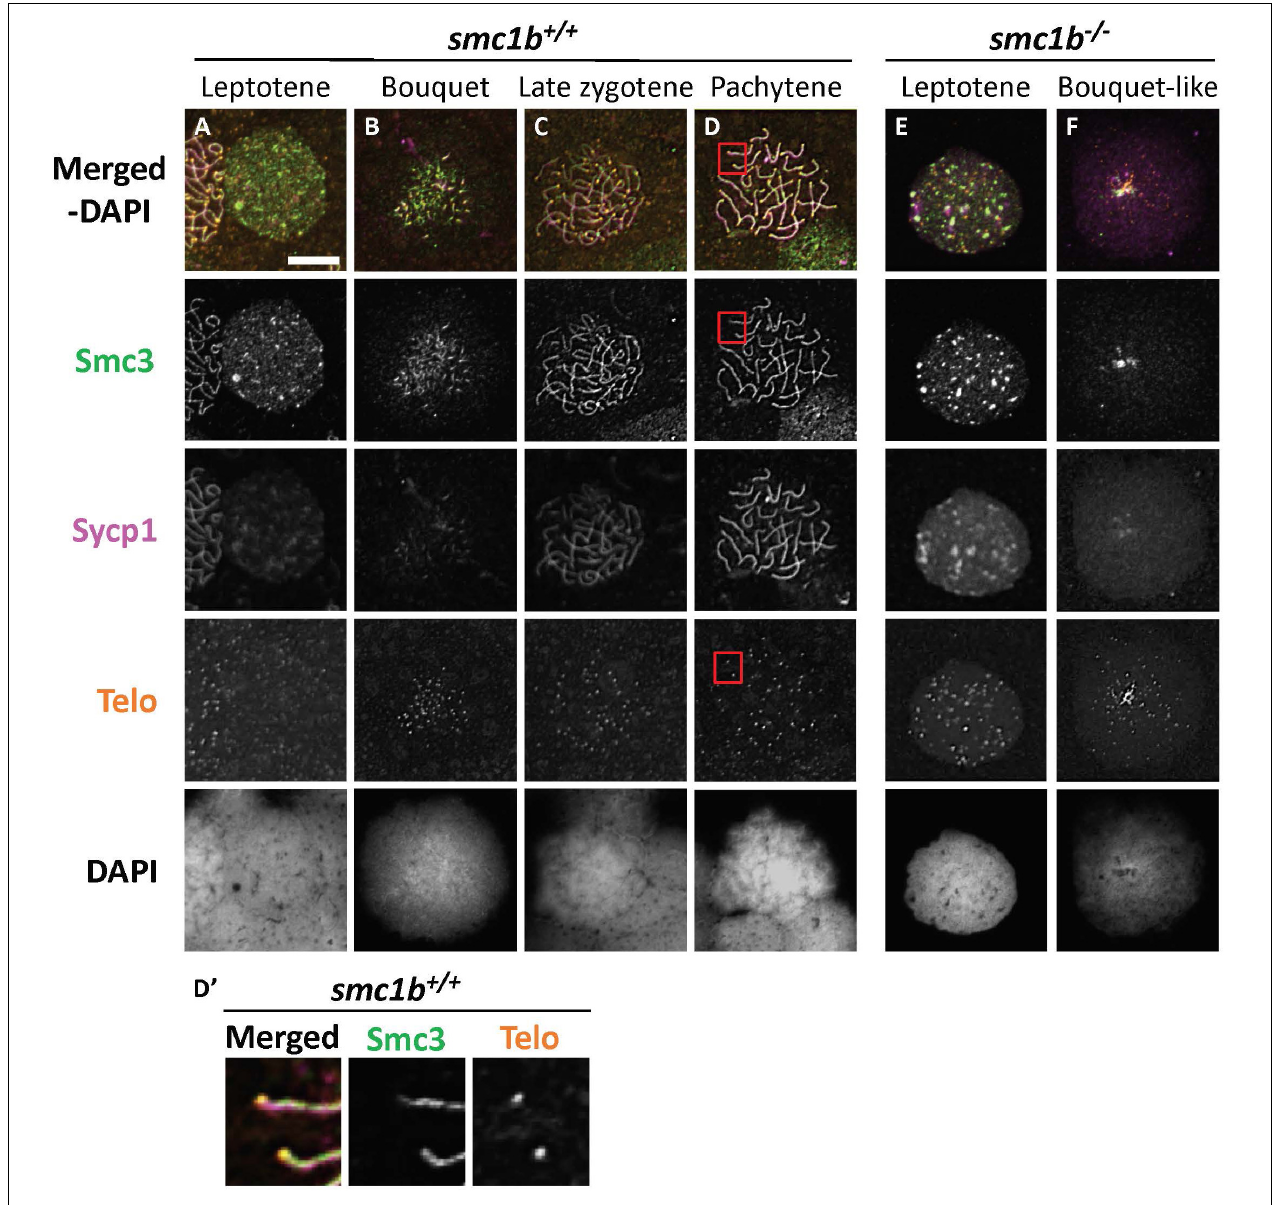
FIGURE 6 | The cohesin complex does not associate with meiotic chromosomes in zebrafish spermatocytes. (A–E) Immunolabeling of Smc3, and Sycp1 in wild-type (A–D) and smc1b mutant (E,F) chromosome spreads. (A–D) In wild-type cells, Smc3 showed a localization pattern similar to Sycp1. (D (cid:48) ) Smc3 was not enriched at telomeres. Images show enlarged views of the red-boxed areas in panel (D) . (E,F) In mutant cells, Smc3 was expressed in leptotene stage but failed to load onto chromosomes. Scale is 10 µ m.